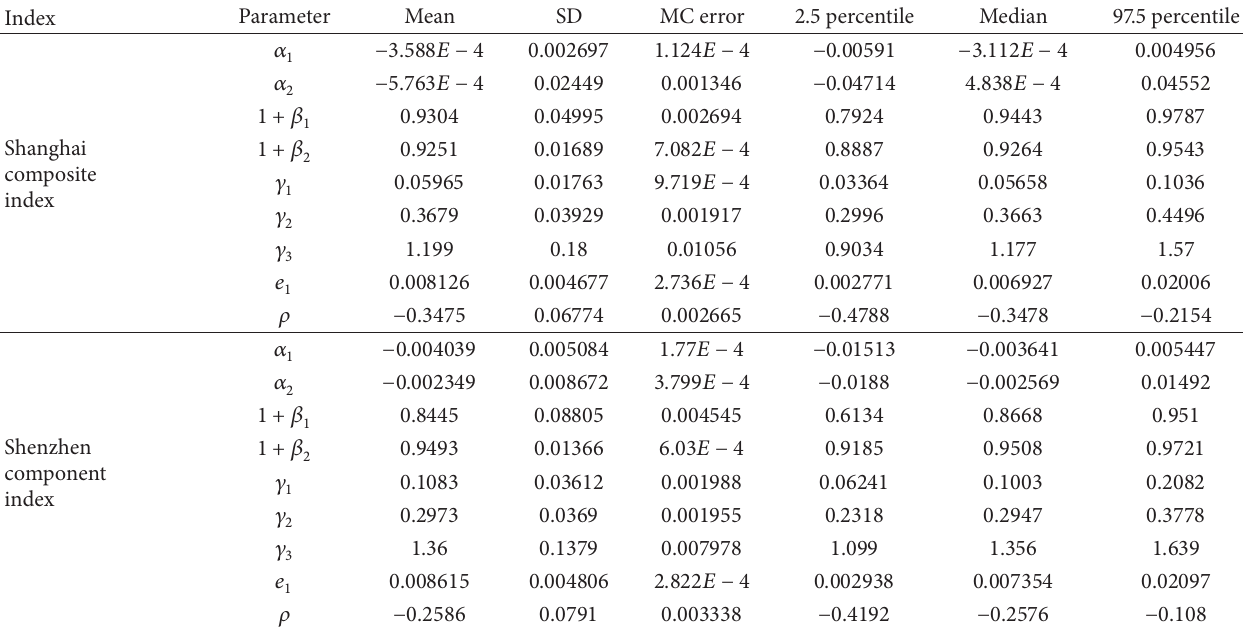
Table 3: Empirical estimation results for two